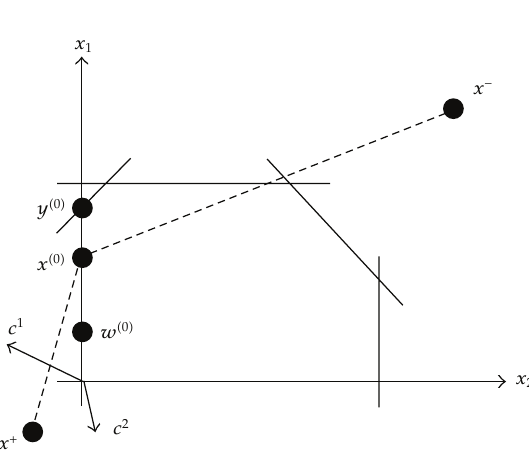
Figure 3: Compromise solution in iteration